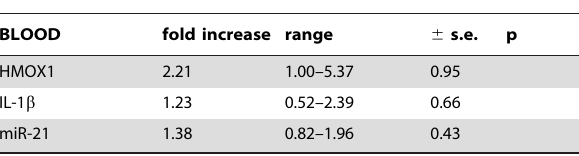
Table 5. Blood/plasma